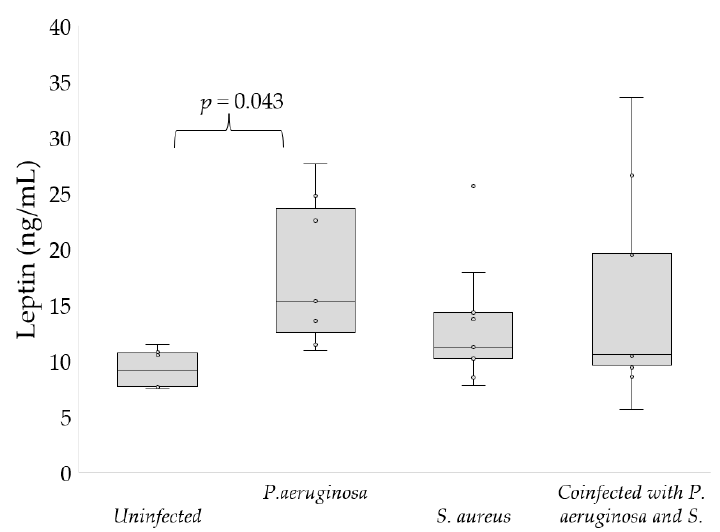
Figure 2. Levels of leptin depending on the type of bacterial infection.